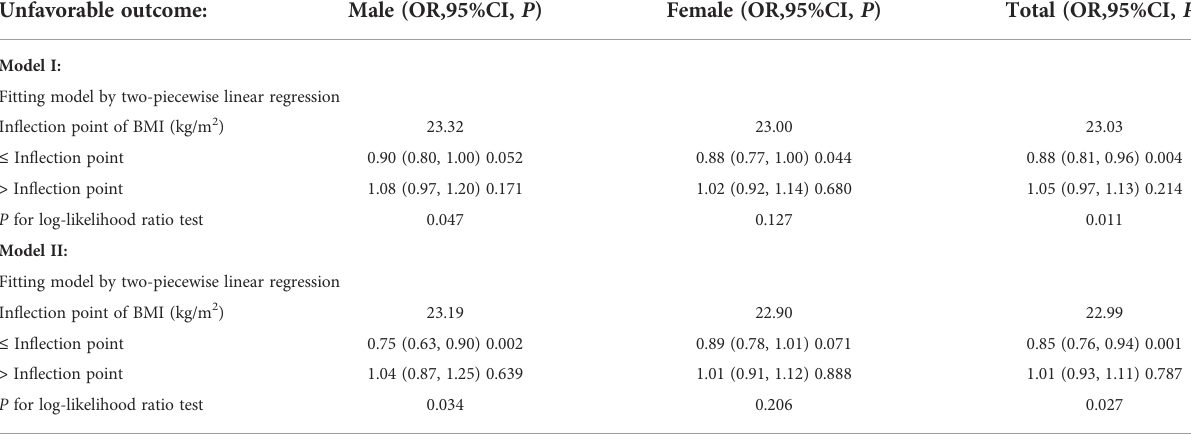
TABLE 5 Relationship between BMI and unfavorable outcome 3-month after stroke analyzed by two-piecewise linear regression model in different sensitivity analyses. Unfavorable